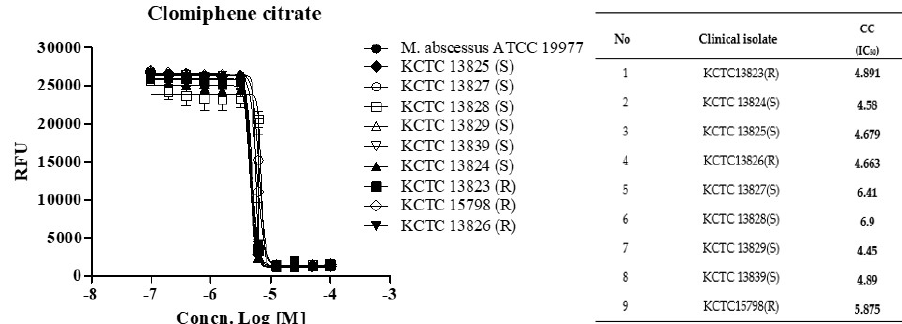
Figure 2. The activity of CC against M. abscessus clinical isolates. Dose-response curves (DRC) were plotted from the REMA data for isolates treated with CC. Data were expressed as the mean ± standard deviation (SD) of triplicates for each concentration. Analysis of DRC graph and IC 50 using GraphPad Prism 5.0. RFU, relative fluorescence units. This result was made from a representative experiment.